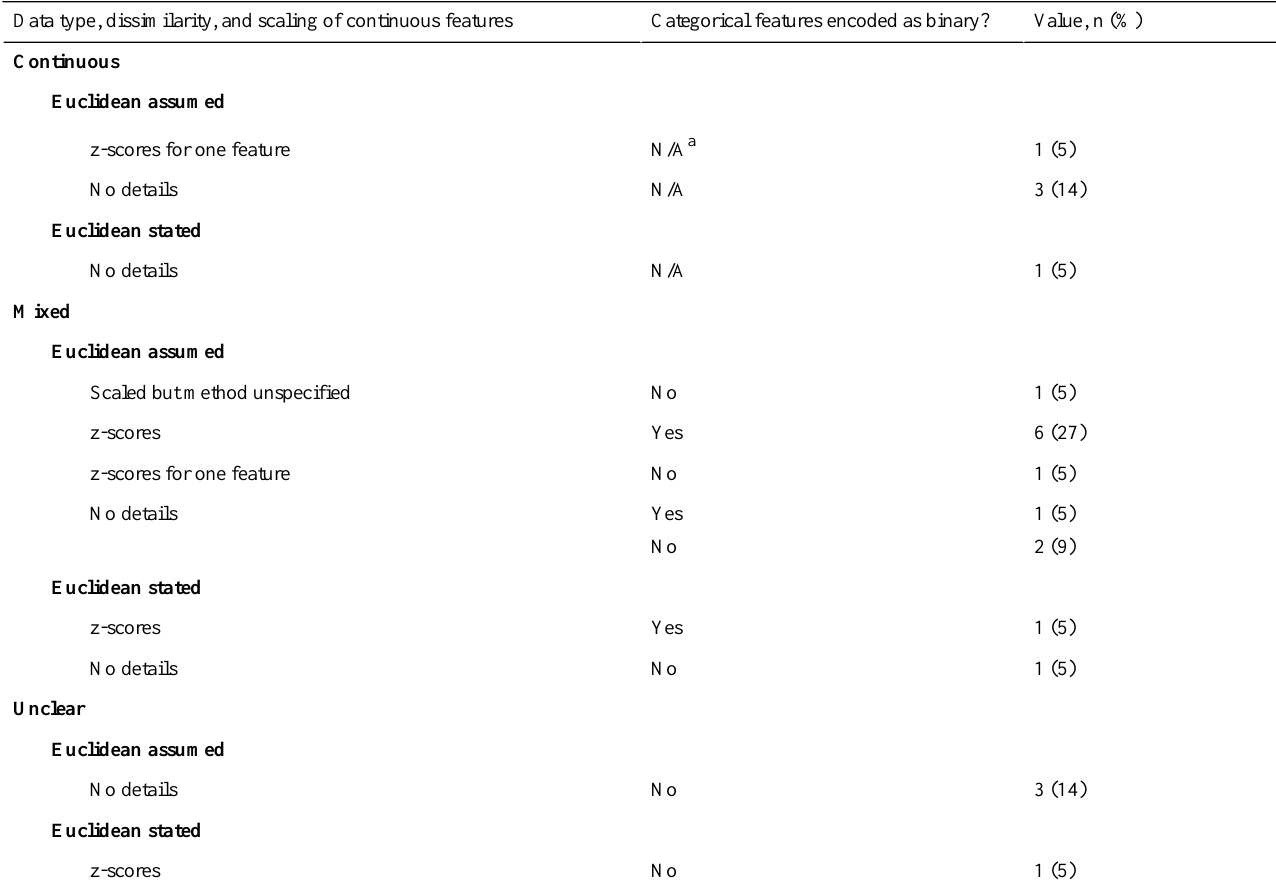
Table 3. Breakdown of methods used by studies applying k-means (N=22).